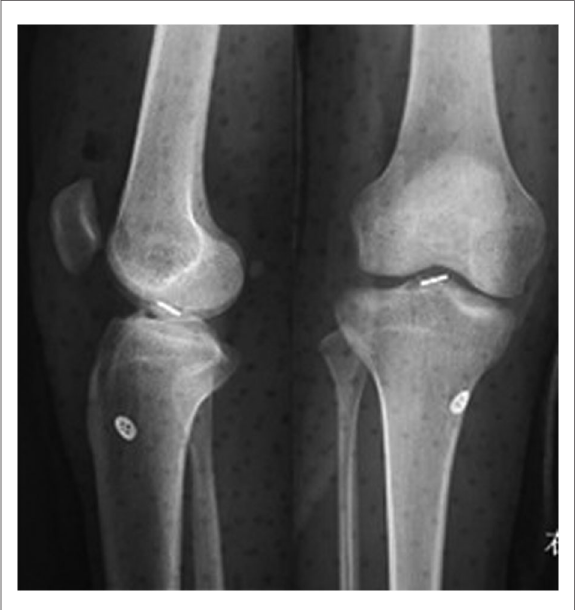
FIGURE 8 Postoperative anterior-posterior and lateral view radiographs. The nearly ideal position ( B